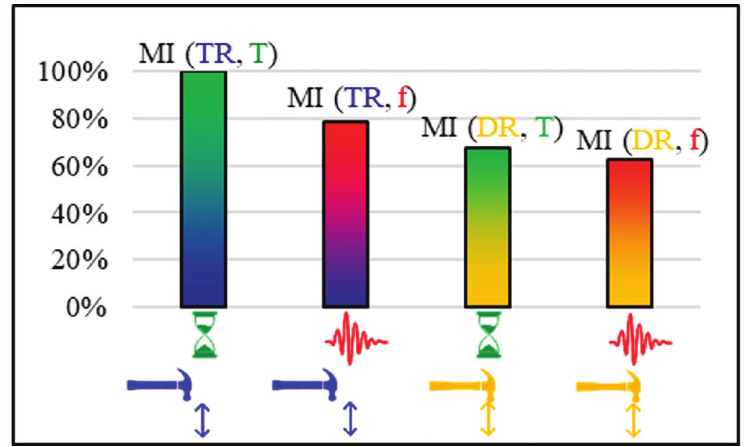
Figure 13. Simplified